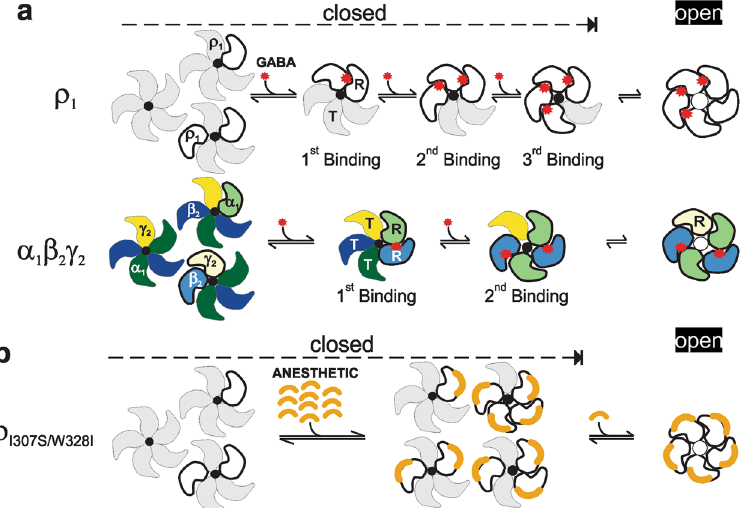
Figure 6. A model of GABA- versus anaesthetic-dependent activation. ( a ) A model of the GABA-dependent activation of α 1 β 2 γ 2 compared to that of the ρ 1 GABA A receptors. T and R represent tense and relaxed states, respectively. Note that in this model, a single GABA binding can stabilize two subunits into a relaxed state and cast a more widespread effect on the overall structure. For the α 1 β 2 γ 2 receptor, the intermittent binding of two GABA molecules can stabilize four subunits into a relaxed state, while for the ρ 1 receptor, three consecutive GABA binding events (three GABA molecules) are needed to achieve the same task. ( b ) Represents the distinct model of the anaesthetic-dependent activation of the mutated ρ 1 receptors. In the presented model, the anaesthetics produce a local and limited effect on the state of the